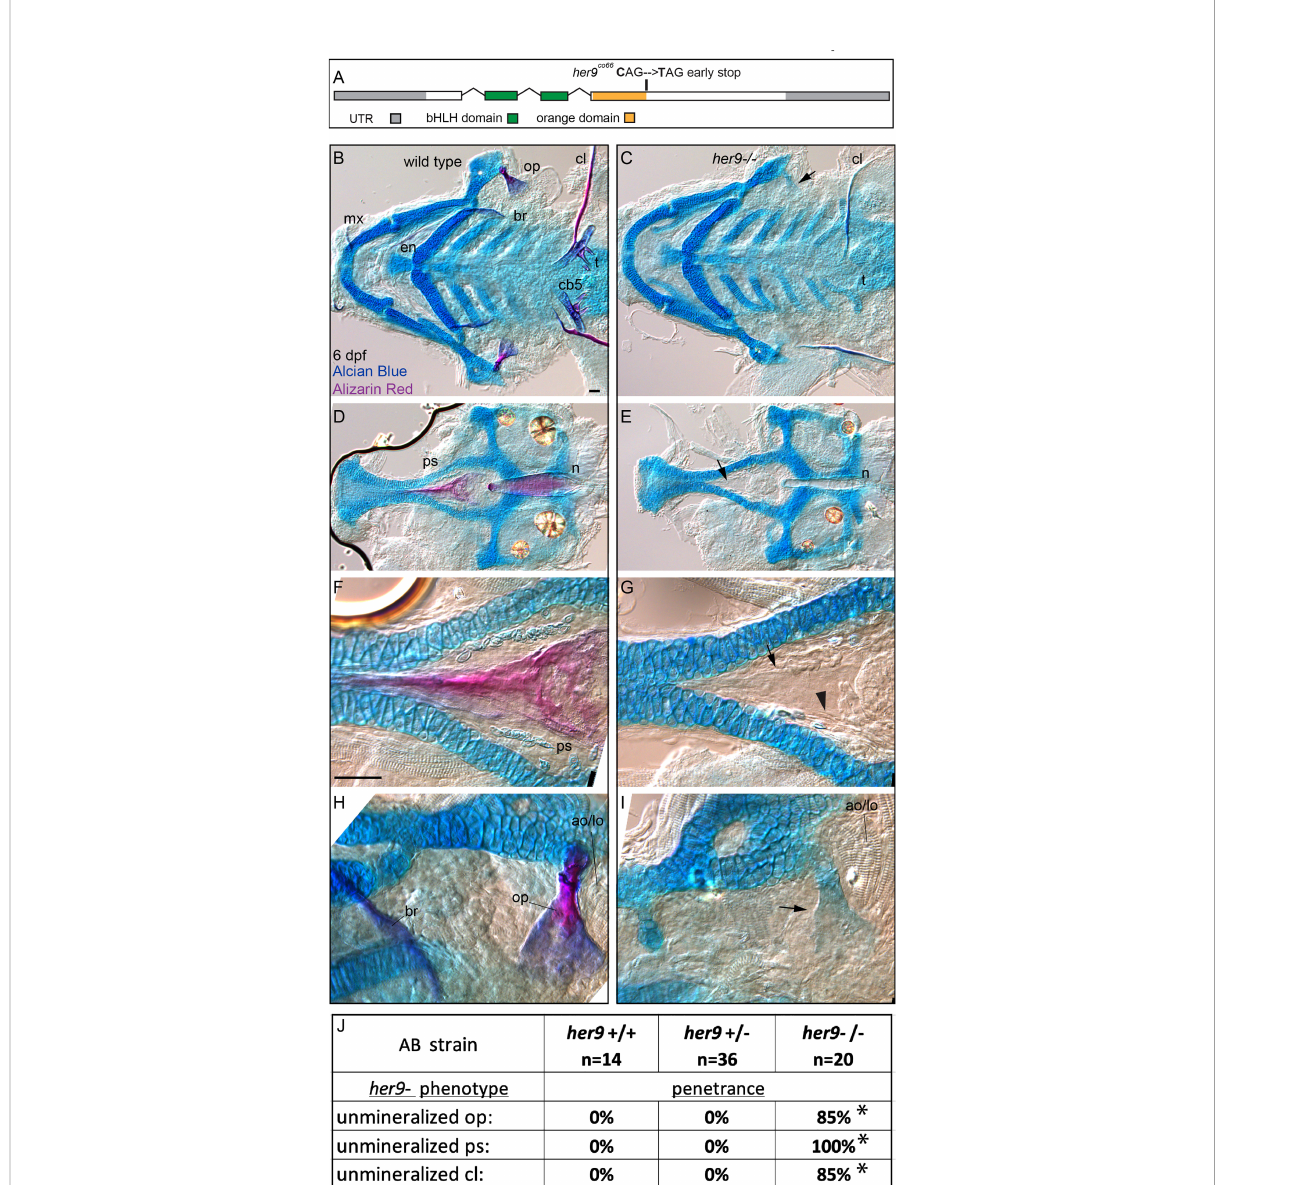
FIGURE 2 her9 is required for ef fi cient mineralization. (A) Exon diagram for her9 indicating the untranslated regions (UTR) and the regions predicted to encode the basic helix-loop-helix (bHLH) and Orange domains. The location of the early stop encoded by the her9 co66 allele is indicated. (B, C) Zebra fi sh heterozygous for her9 were pairwise intercrossed and six days post fertilization (dpf) larvae were stained with Alcian Blue and Alizarin Red to label cartilage and bone. The individuals were then genotyped, the viscerocrania were dissected, fl at mounted, and then imaged. The following craniofacial skeletal elements are indicated in the wild-type individual: opercle bone (op), branchiostegal ray (br), maxilla (mx), entopterygoid (en), ceratobranchial 5 (cb5) bone, teeth (t), and the cleithrum (cl). Arrow in C indicates the unmineralized, Alcian Blue-positive opercle. Scale bar is 50 m m (D, E) The neurocrania from the same experiments as B and C were dissected, fl at mounted, and then imaged. The parasphenoid bone (ps) and notochord (n) is indicated in the wild-type individual. Arrow in D indicates the shadow bone where the mineralized parasphenoid would be observable in wild types. (F, G) Enlargements from D and E. Arrow indicates the unmineralized shadow bone. Arrowhead denotes osteoblast-shaped cells surrounding the shadow bone. Scale bar is 50 m m (H, I) Enlargements from (B, C) . The adductor operculi and the levetor operculi muscles (ao/lo) are indicated. Arrow in I indicates the unmineralized, Alcian Blue-positive opercle with the adductor operculi and the levetor operculi muscles (ao/lo) attached. (J) The penetrance of her9 mutant-associated phenotypes observed in 6 dpf larvae for each genotype are indicated. Asterisk indicates signi fi cant difference (p<0.05) in penetrance between the indicated genotype and wild type by Fishers exact